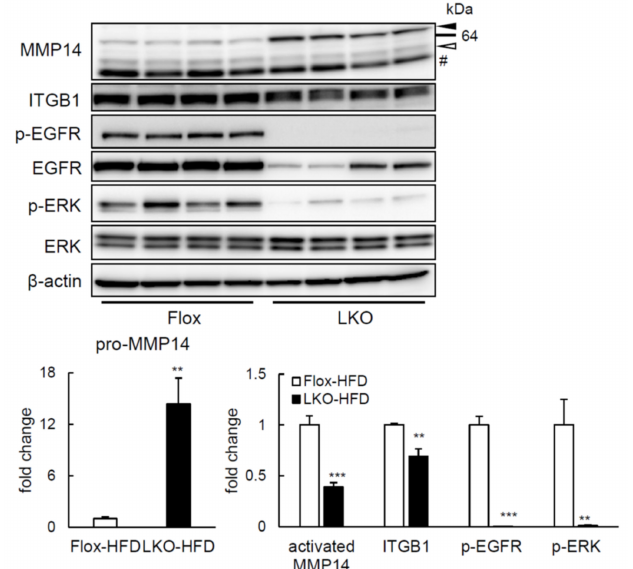
Figure 6. LKO mice inactivated MMP14 cascades. Western blotting analysis and quantifica- tion of MMP14 cascade in the Flox/LKO mice under feeding HFD after overnight fast (14 h) (n = 4 per group). A solid arrow head; pro-MMP14, an open arrow head; activated MMP14, #; nonspecific bands. Phospho-EGFR and -ERK were normalized to total EGFR and ERK, respectively. Other proteins were normalized to β -actin. Values are shown as the mean ± SEM; ** p -value < 0.01 and *** p -value < 0.001 ( t